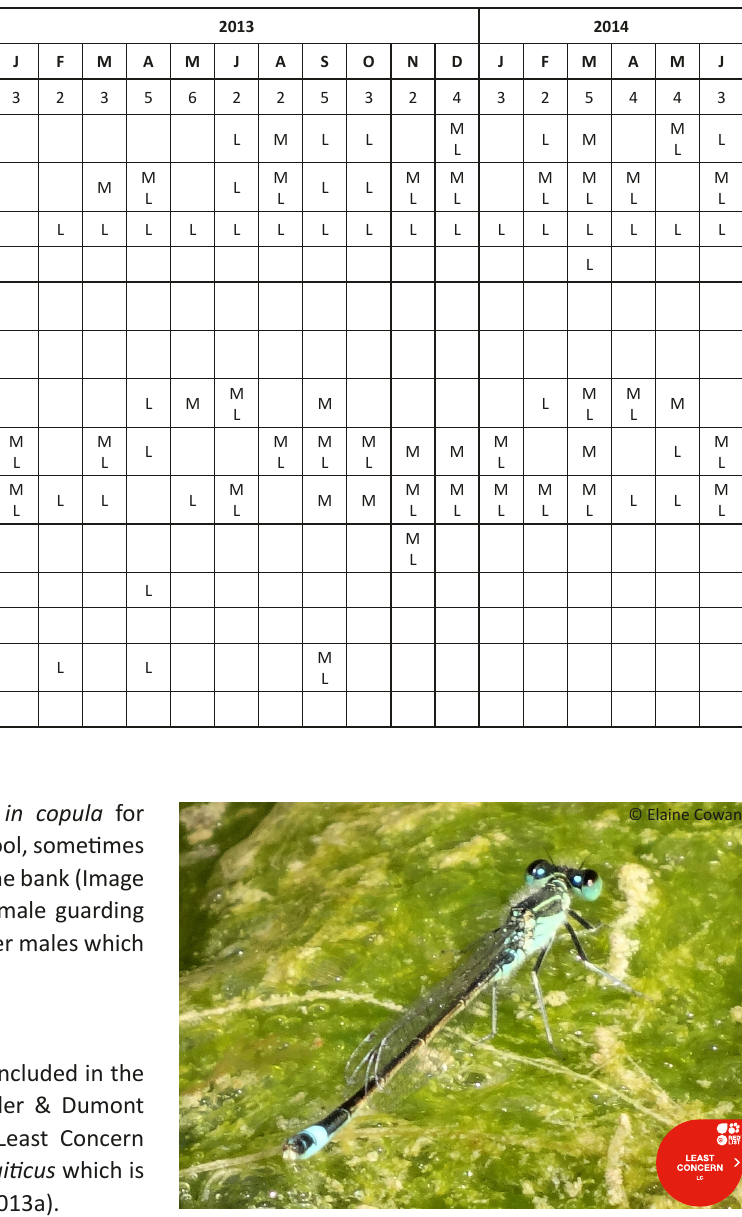
Table 3. Monthly occurrence of mating and laying by odonate species at the wadi pool, March 2012 to June 2014. No visit was made June, July, November, December 2012 and July 2013. M - mating photographed. L - laying photographed. For example, Anax imperator was photographed laying on at least one of the visits May 2012.